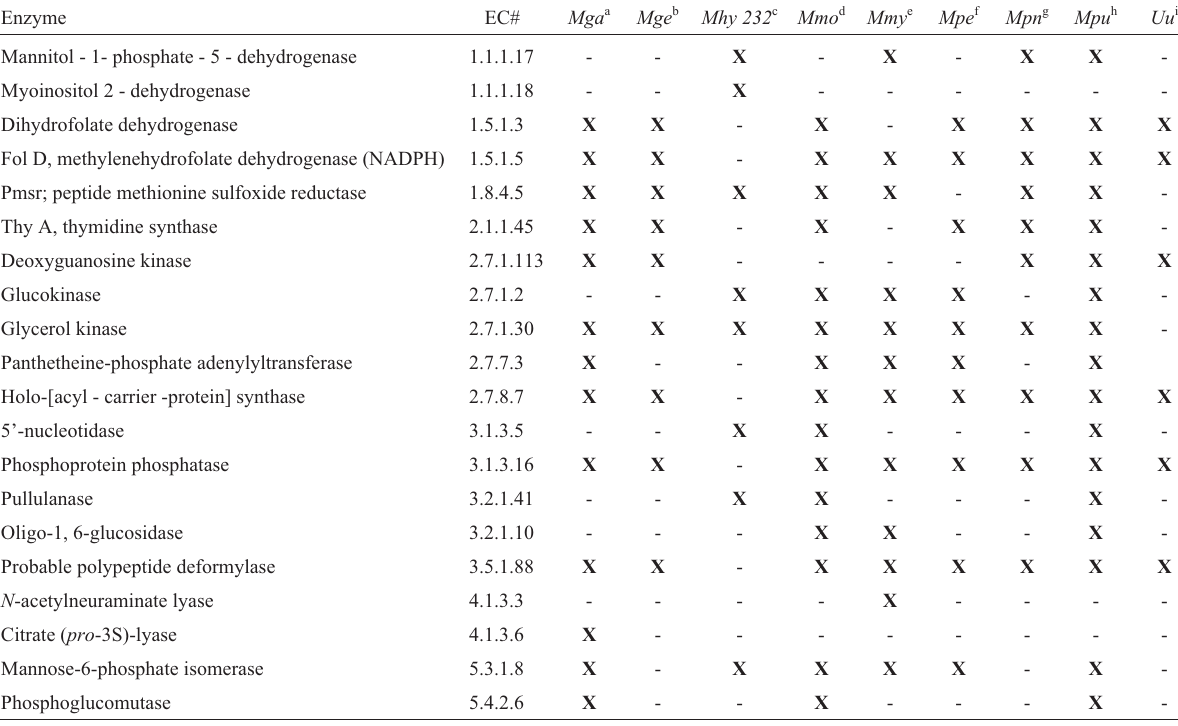
Table 2 - Distribution of differential sequences encoding enzymes of other Mycoplasma and Ureaplasma species. Enzyme